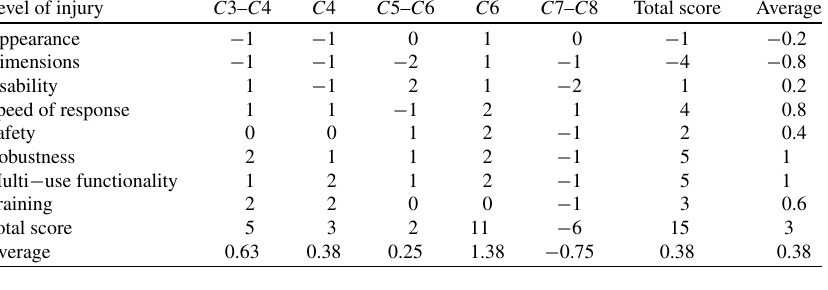
Table 5 Overall assessment